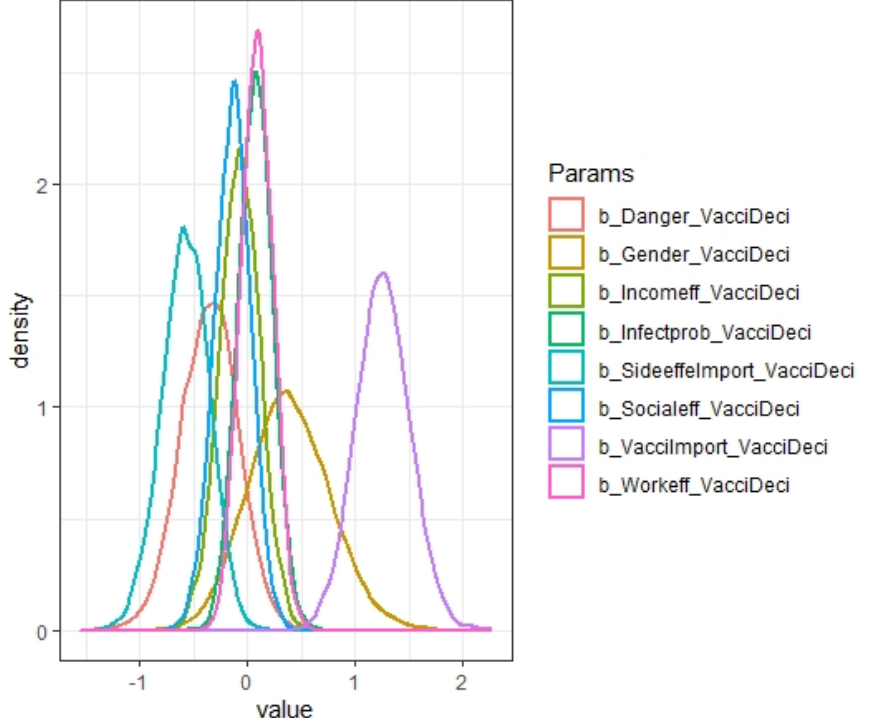
Figure 6. Posterior coefficients of the vaccination decision model.